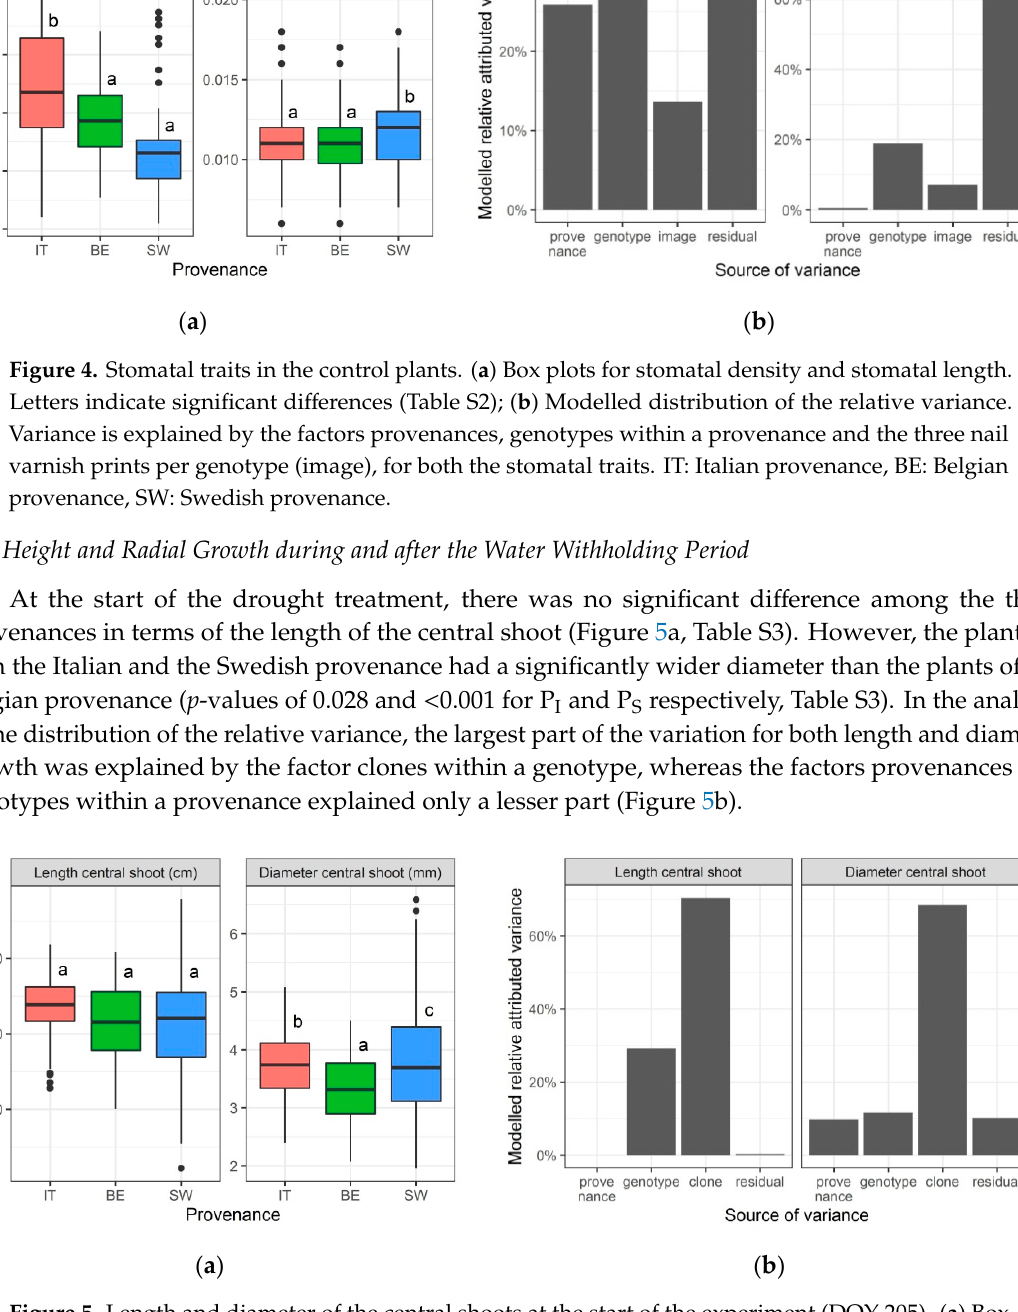
Figure 5. Length and diameter of the central shoots at the start of the experiment (DOY 205). ( a ) Box plots of the measurements. Letters indicate significant differences (Table S3); ( b ) Modelled distribution of the relative variance. Variance is explained by the factors provenances, genotypes within a provenance and clones within a genotype. IT: Italian provenance, BE: Belgian provenance, SW: Swedish provenance.